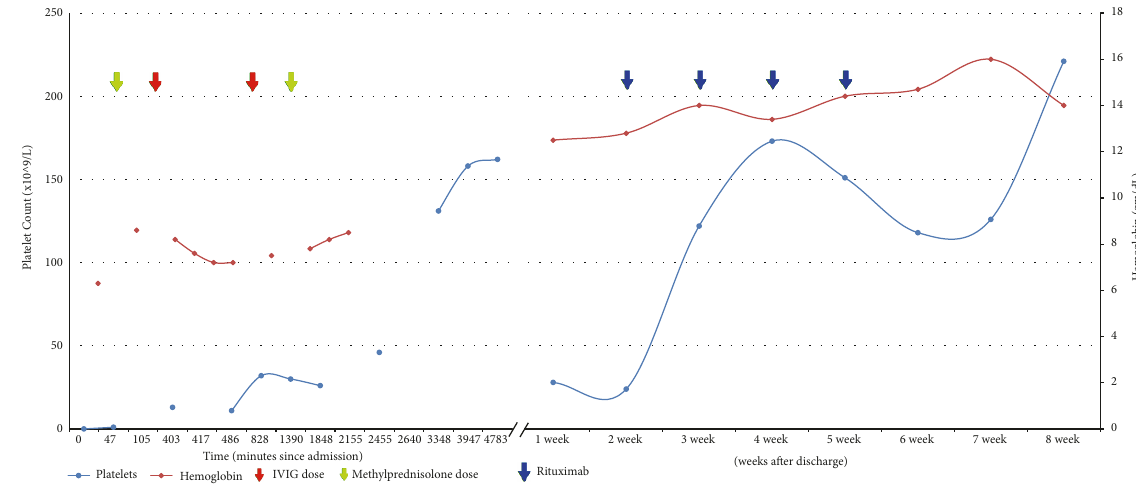
Figure 3: Laboratory values during the patient’s course. IVIG, intravenous